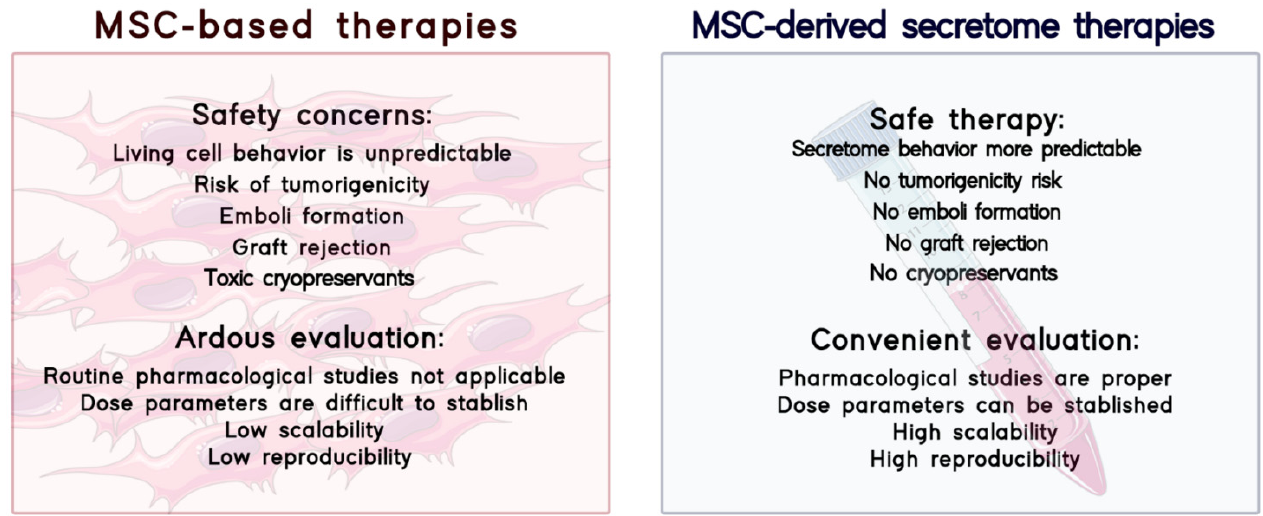
Figure 2. Comparison between MSC-based therapies and MSC-derived secretome therapies in terms of safety and evaluation of therapies.